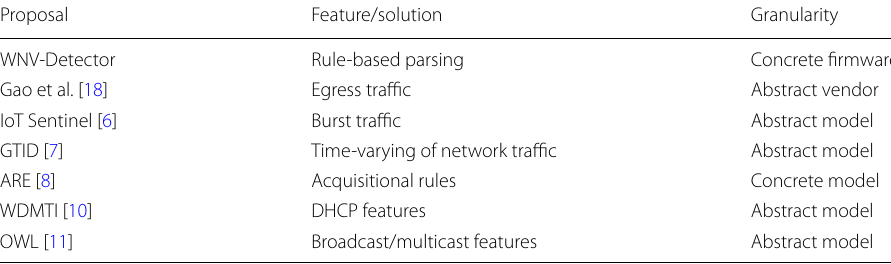
Table 3 Comparison of similar schemes Proposal